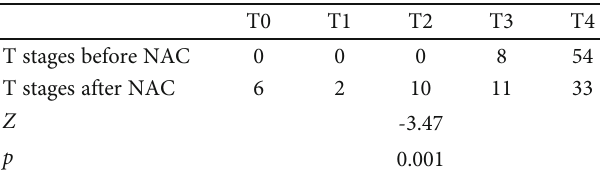
Table 3: Di ff erences in T stages between before NAC and after surgery.